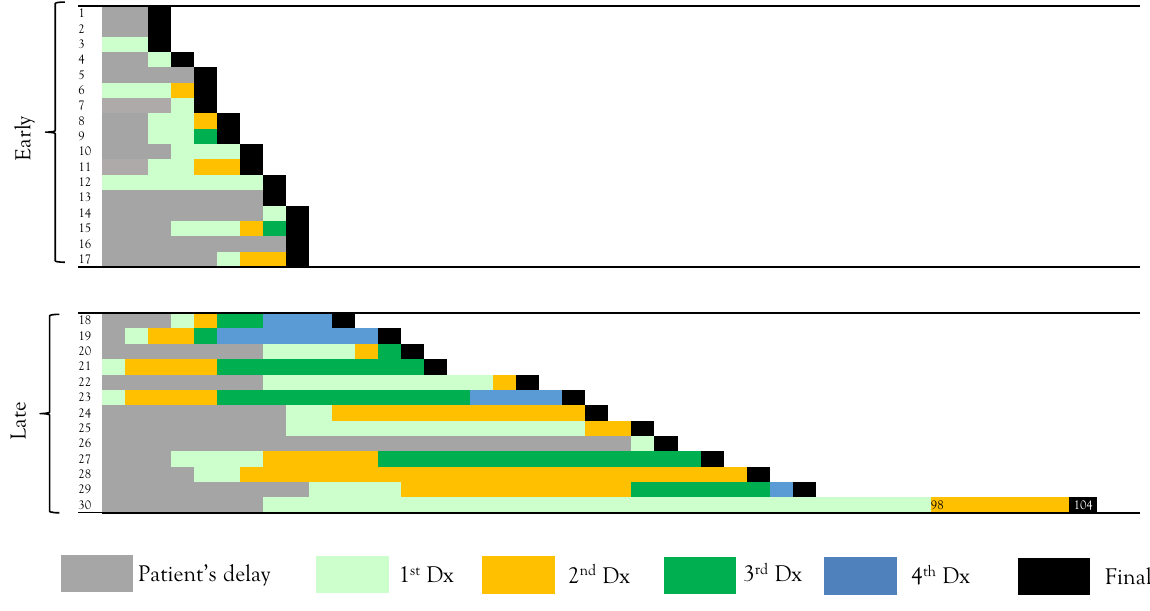
Figure 2. Overall diagnostic delay in paediatric ADEM. Each column shows the diagnostic odyssey plot for each ADEM case. Cases are placed in ascending order of their overall diagnostic delay. Early-diagnosed cases are those diagnosed ≤ 9 days after symptom onset. ADEM acute disseminated